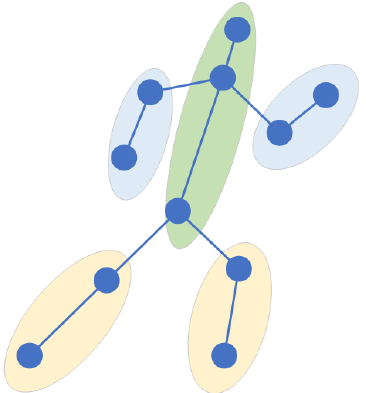
Figure 1. Running: position diagram of arms, legs and